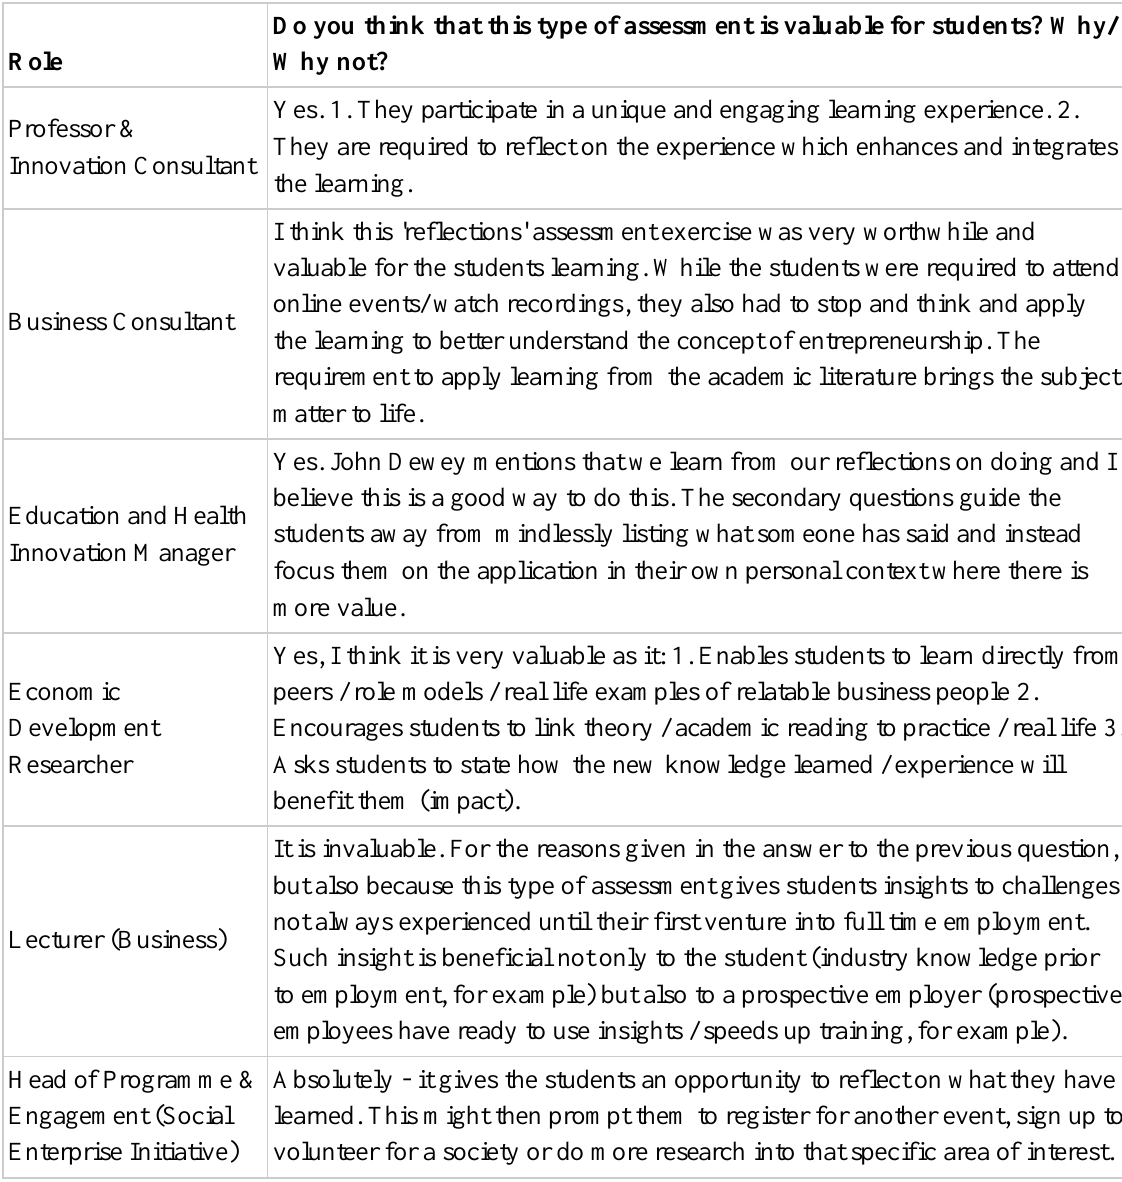
Table 3: Expert Opinion on Reflective